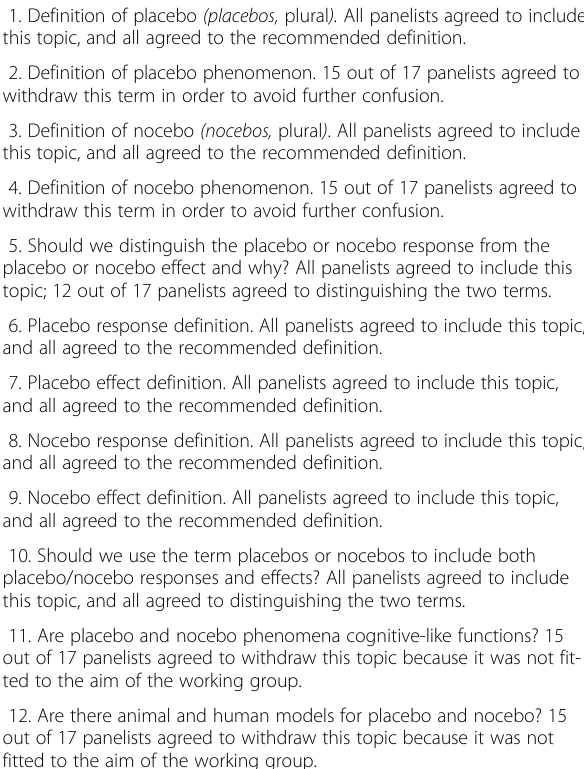
Table 1 The 12 initial topics for discussion with the relevant decisions and proportion of